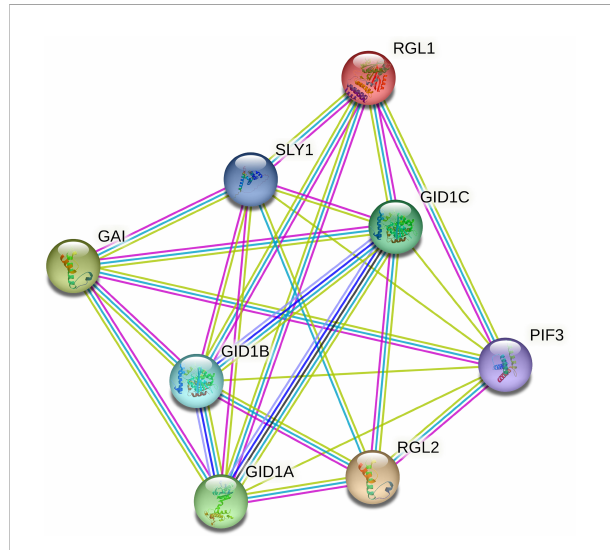
FIGURE 6 Interaction networks of CmoDELLA proteins. The network nodes represent proteins and the edges indicate protein-protein associations.